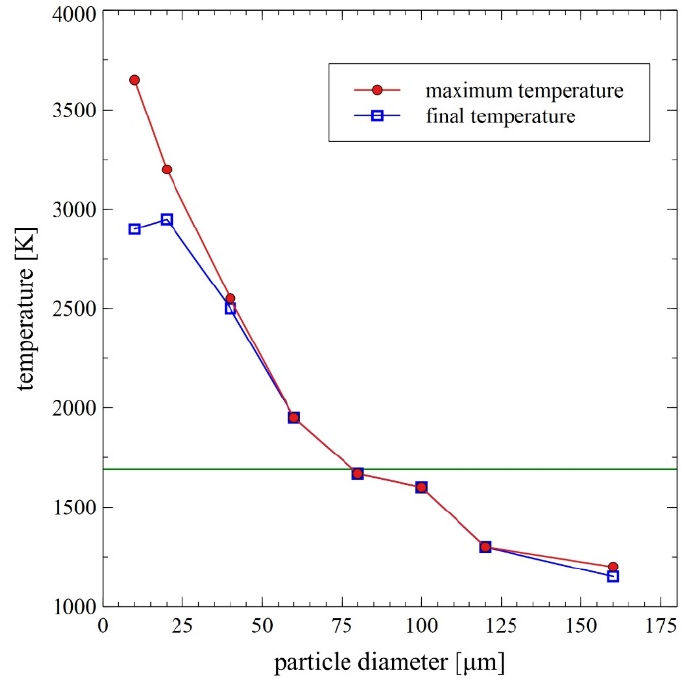
Figure 7. Comparison of the maximum and final particle temperature during the DGS spraying process as a function of the particle diameter—results of the DGS multiphase flow numerical modeling [14] with indication of the temperature of FeAl alloy melting .